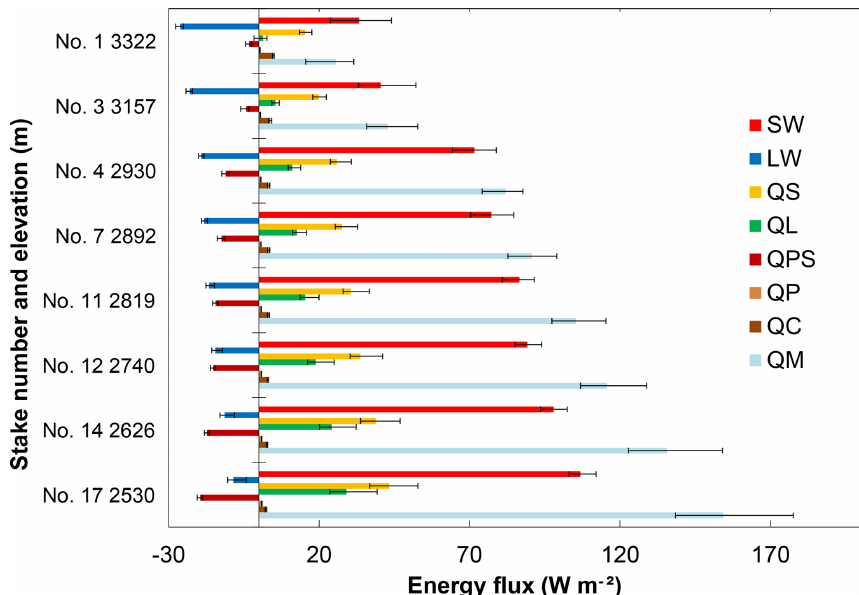
Figure 7. The energy balance components for 8 out of 18 selected stake locations close to the central flow line, displayed in different colours for HEF 2012. Solid bars represent the fluxes of short-wave radiation (SW), long-wave radiation (LW), turbulent heat fluxes ( Q L and Q S ), penetrating short-wave ( Q PS ), precipitation heat flux ( Q P ),conductive heat flux ( Q C ) and the resultant available heat for melting ( Q M , here plotted as a positive flux).